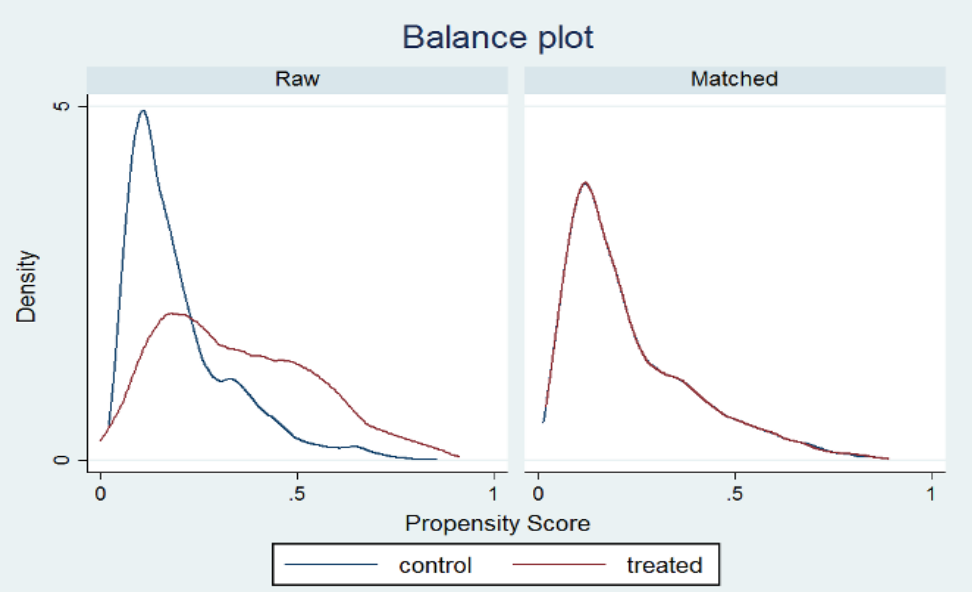
Figure A1: Overlap and density balance for housing insecurity